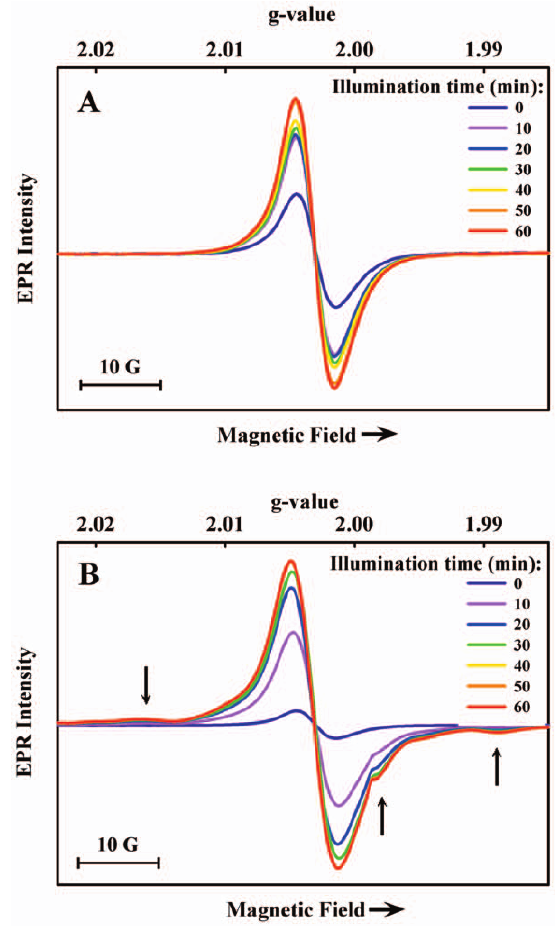
Figure 3. EPR spectra (77 K) of melanized C.neoformans cells after Xe-lamp illumination. A) cells were illuminated at room temperature for the time periods indicated and frozen immediately after removal from the light source; B) cells were frozen after collection from cultures and were illuminated at 77 K for the time periods